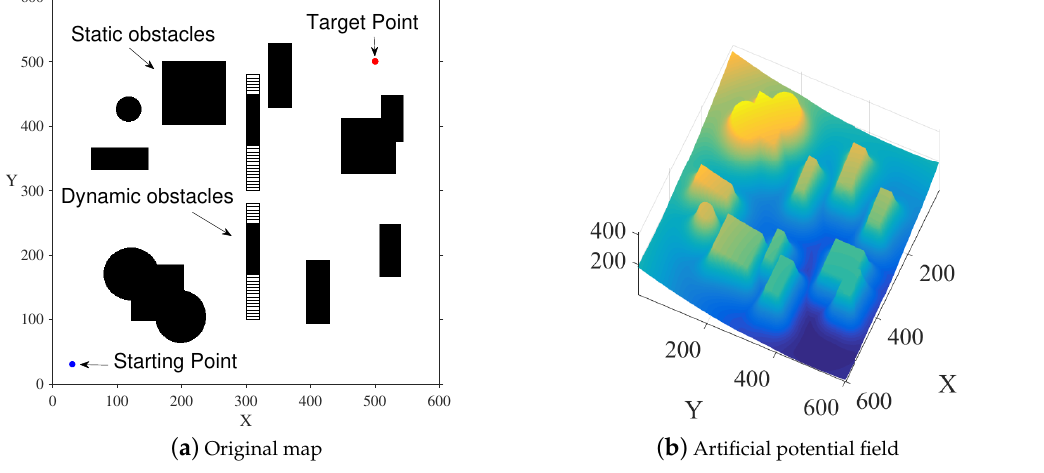
Figure 2. Original map and artificial potential field (APF)